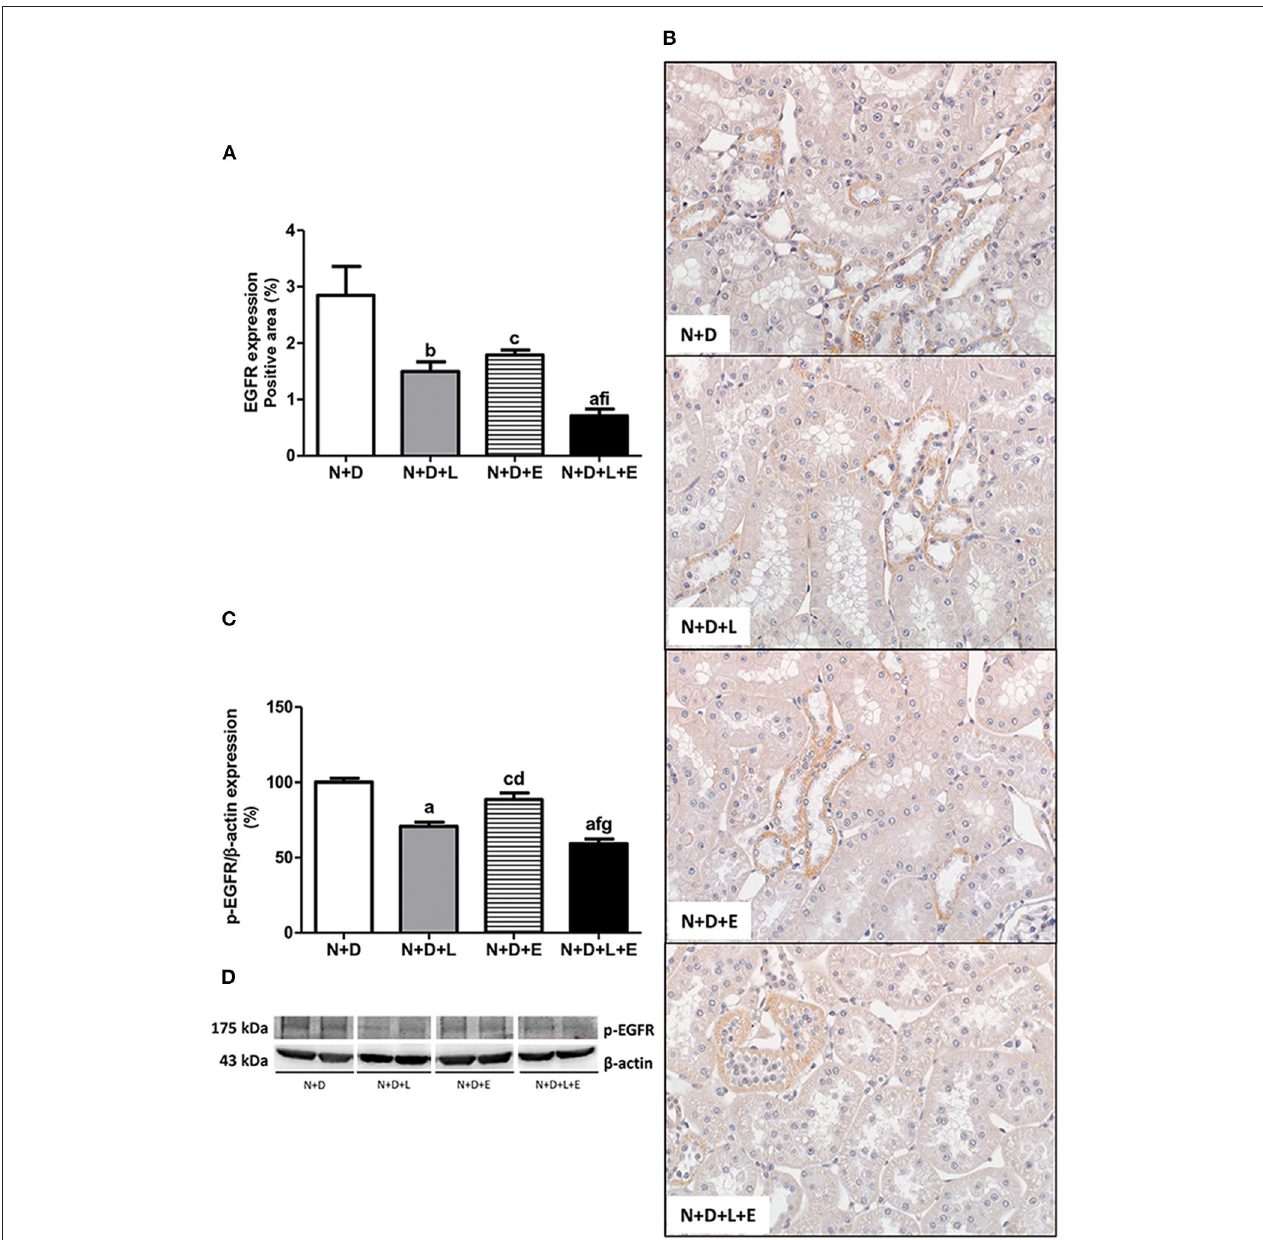
FIGURE 6 | Assessment of both epidermal growth factor receptor (EGFR) and phospho-EGFR (p-EGFR) expression in the renal cortex evaluated 60 days after 5/6 nephrectomy in vitamin D-deficient rats treated with losartan, erlotinib or losartan + erlotinib. (A) Bar graph of immunohistochemical analysis of EGFR in the N + D, N + D + L, N + D + E, and N + D + L + E groups. (B) Representative photomicrographs of immunostaining for EGFR in the renal cortex from a N + D, N + D + L, N + D + E, and N + D + L + E rat (x400). Note that EGFR expression is significantly lower in the N + D + L + E than in the other groups. (C) Semiquantitative immunoblotting for p-EGFR with the respective densitometric analysis of samples. (D) Representative immunoblots which reacted with anti-p-EGFR revealing a 175 kDa band. Data are mean ± SEM. a p < 0.001, b p < 0.01, c p < 0.05 vs. N + D; d p < 0.001, f p < 0.05 vs. N + D + L; g p < 0.001, i p < 0.05 vs. N + D + E. N, 5/6-nephrectomized rats; D, vitamin D-deficient rats; L, losartan-treated rats; E, erlotinib-treated rats; L + E, rats concomitantly treated with losartan + erlotinib. N + D ( n = 10); N + D + L ( n = 8); N + D + E ( n = 7); N + D + L + E ( n = 10).